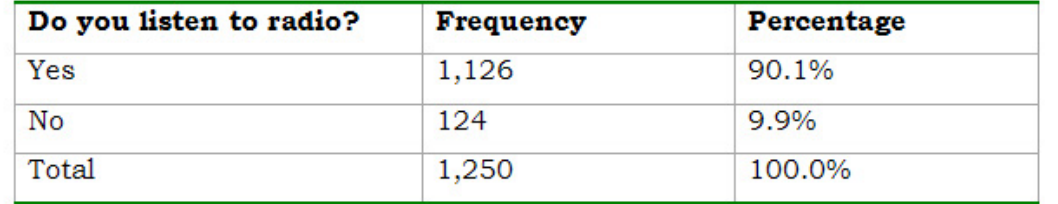
Table 5. Frequency distribution of listening